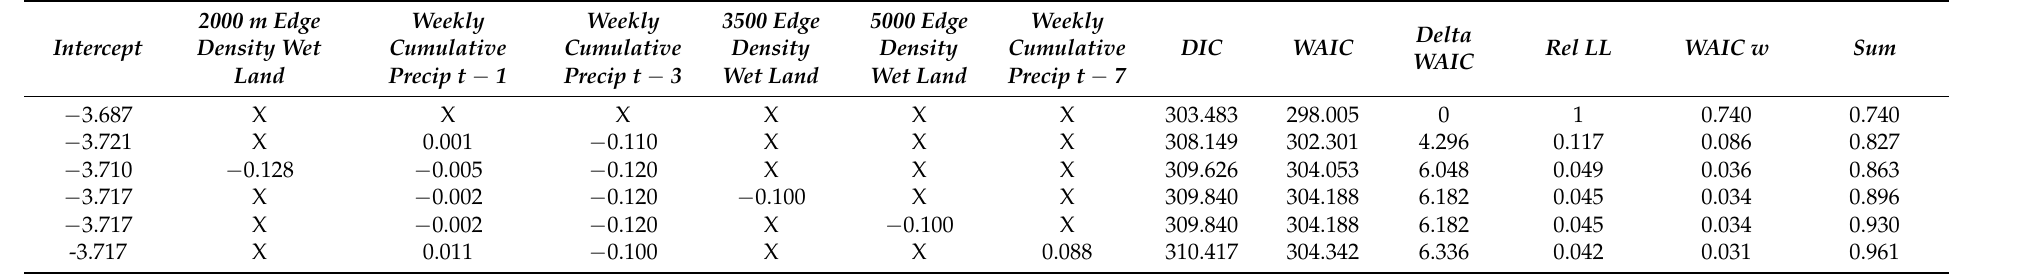
Table 2. The 95% confidence set of models for WNV based on the cumulative sum of the WAIC weights. An “X” present in a column cell indicates that the corresponding variable was not included in the